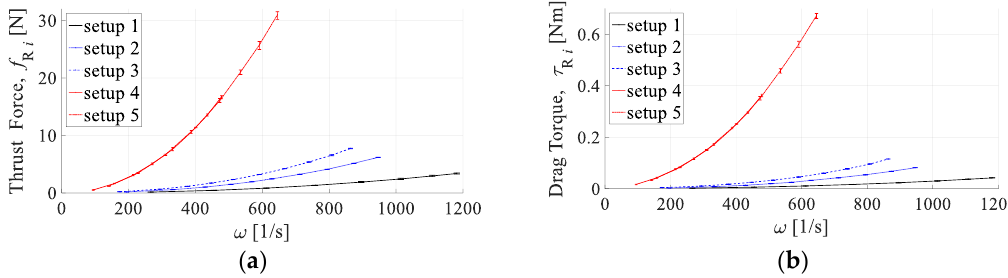
Figure 5. Aerodynamic effects with respect to rotor angular velocity: ( a ) thrust force; ( b ) drag torque.